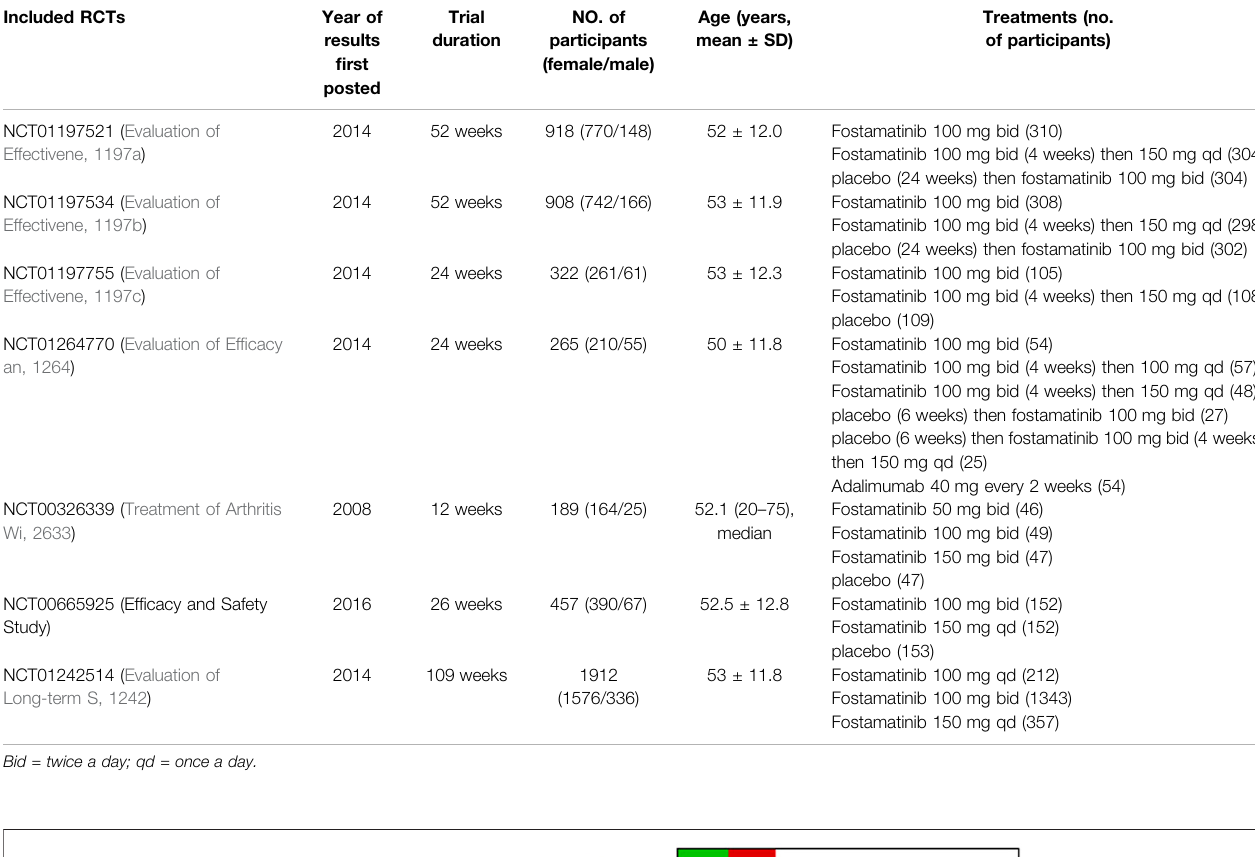
TABLE 1 | Characteristics of included RCTs.